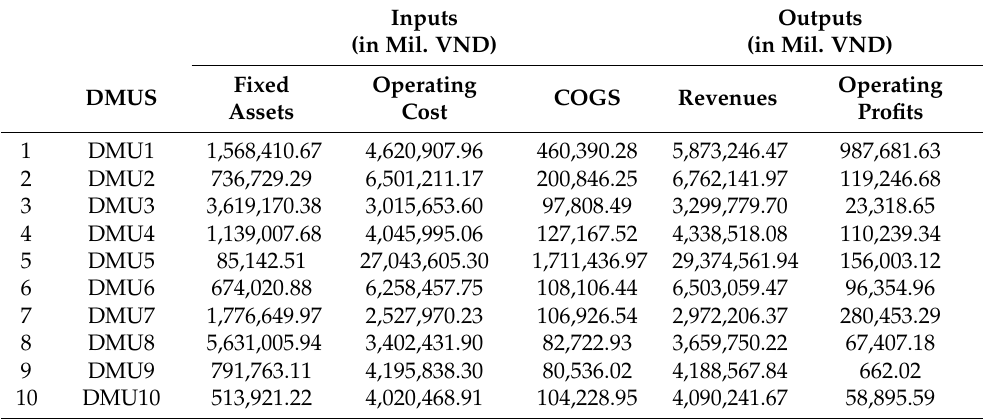
Table 4. Forecasted inputs/outputs data for the year of 2022.